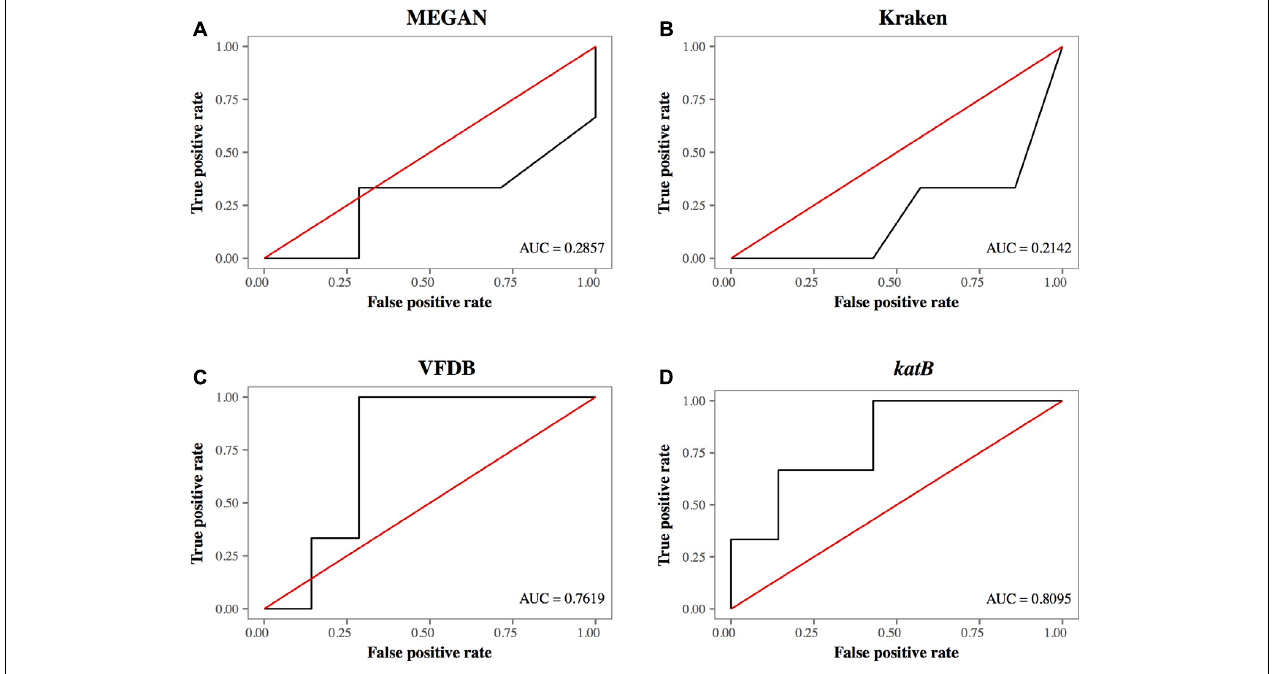
FIGURE 5 | The receiver operating characteristic curves for different database search methods. (A) MEGAN with NCBI-NT database, (B) Kraken with RefSeq archaea, bacteria, and viruses, (C) VFDB, and (D) kat B gene. The red line is the reference line indicating the test without diagnostic benefit, i.e., random